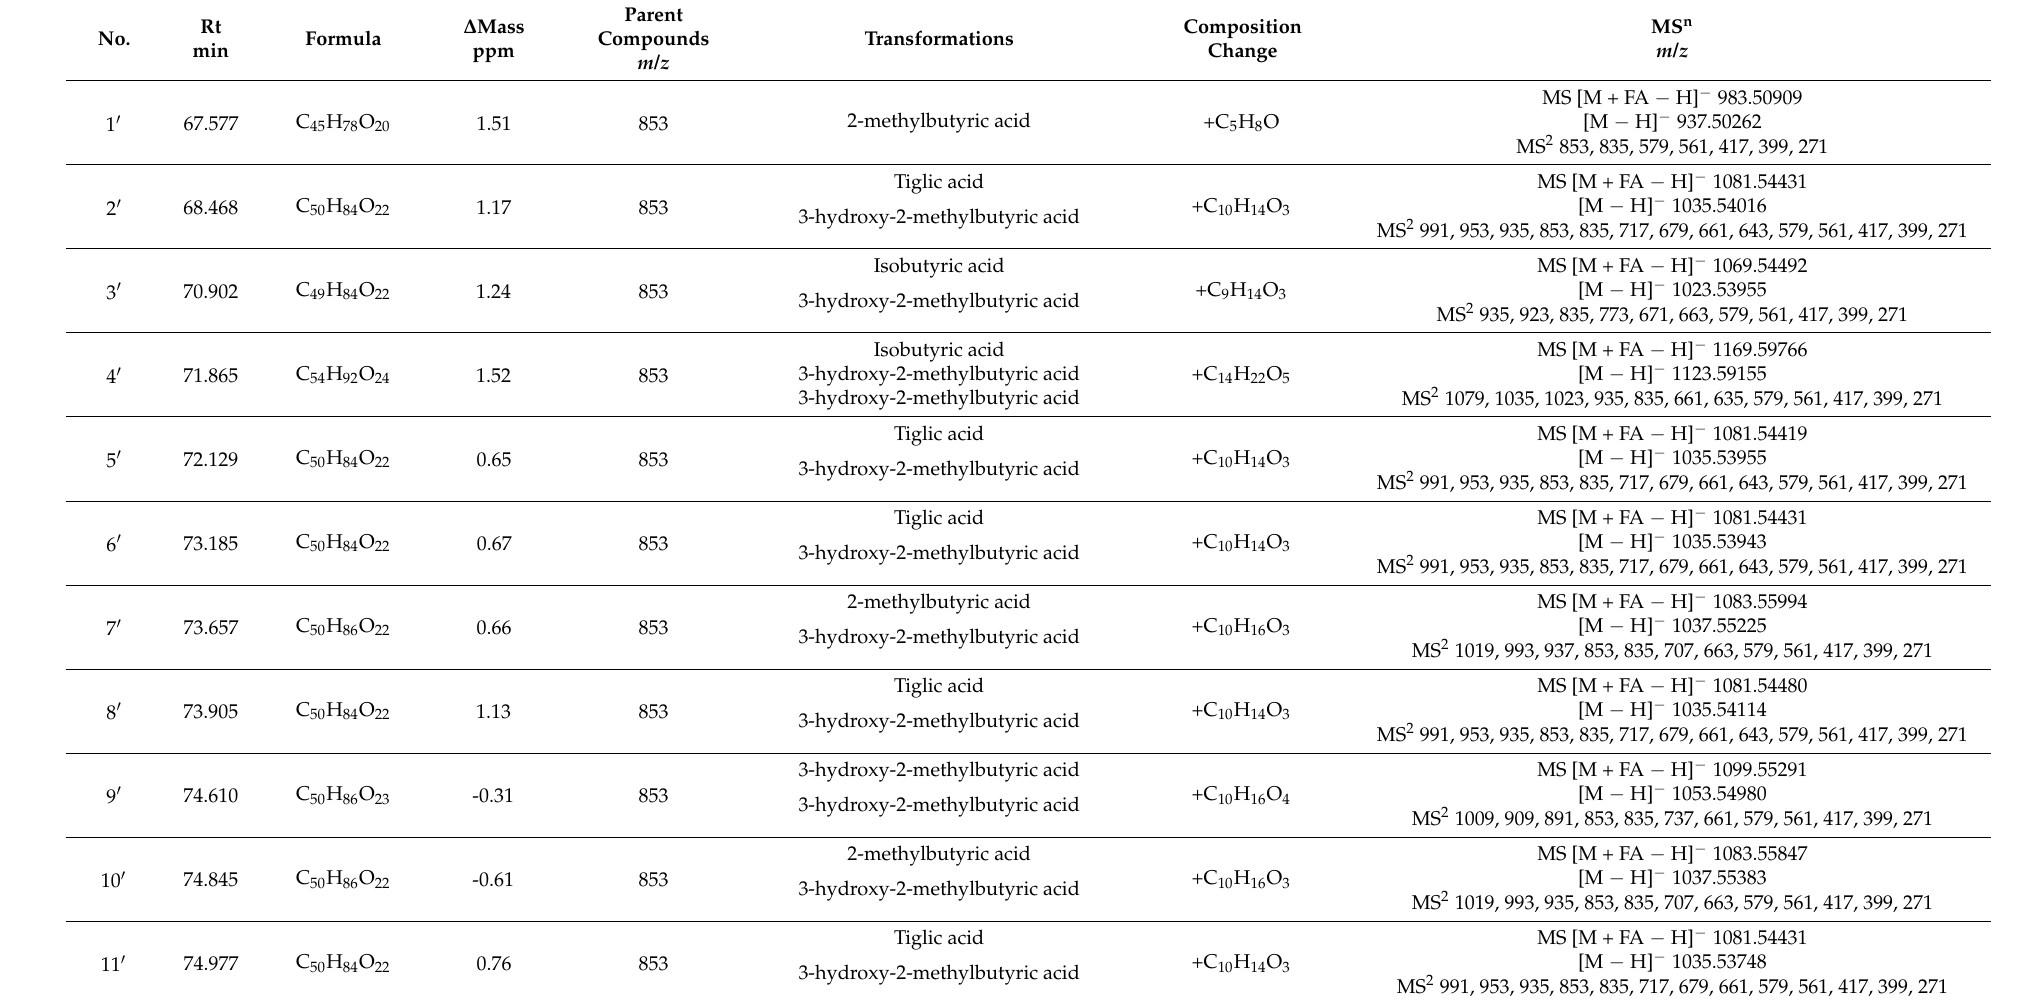
Table 5. Summary of the mass spectral data of characterized resin glycosides in ESI negative ion